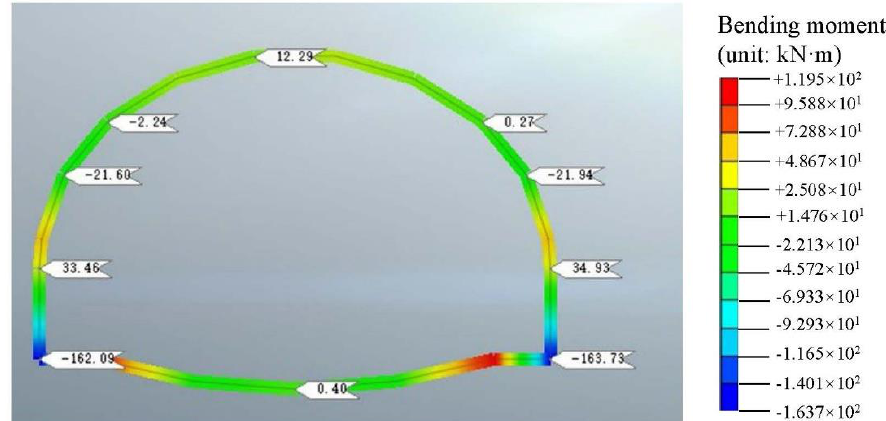
Figure 21. Bending moment diagram of each node of the initial support after treatment.